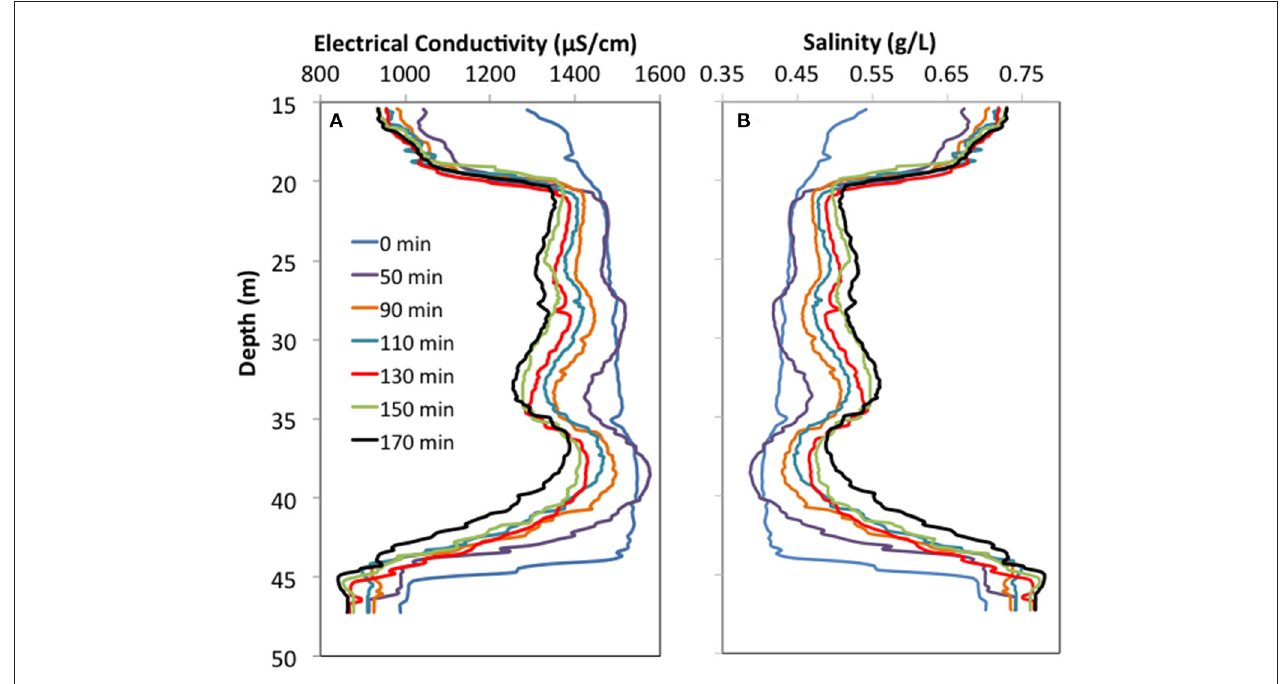
FIGURE 6 | Logging data collected at the NUC well: (A) original FFEC profile (t = 0min, profiles shows the background profile) and (B) modified salinity profile. The modified salinities were obtained from their corresponding ECs by converting them using Eq. 3 and subtracting with a constant salinity value of 1.23 g/L.